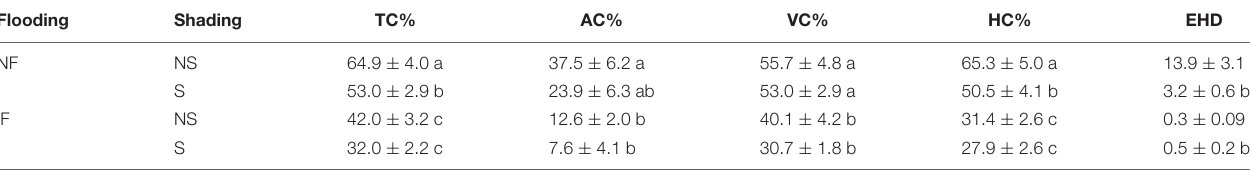
TABLE 2 | Arbuscular mycorrhizal fungi colonization intensity and extraradical hyphal density (EHD, m g − 1 ) in rice roots of Guinongzhan collected at the heading stage from different flooding (NF, non-flooding, IF, intermittent flooding) and shading (S, shading, NS, non-shading) conditions. Flooding